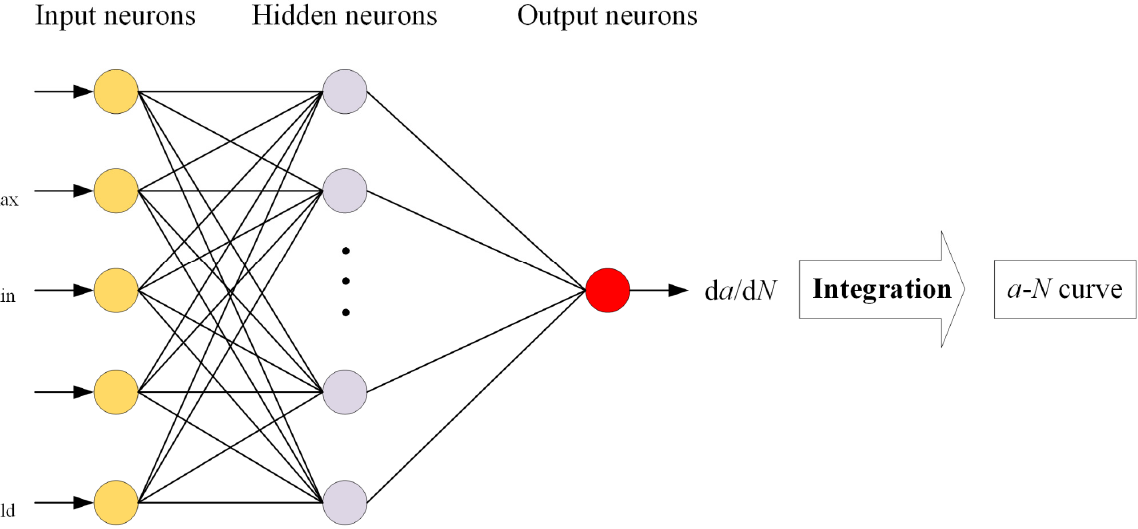
Figure 2. Schematic diagram of NNK method.